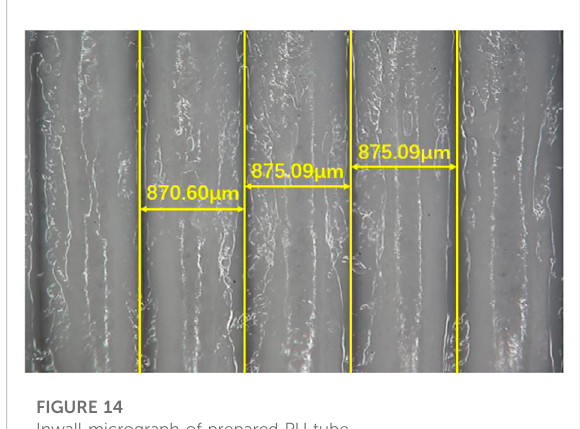
FIGURE 14 Inwall micrograph of prepared PU